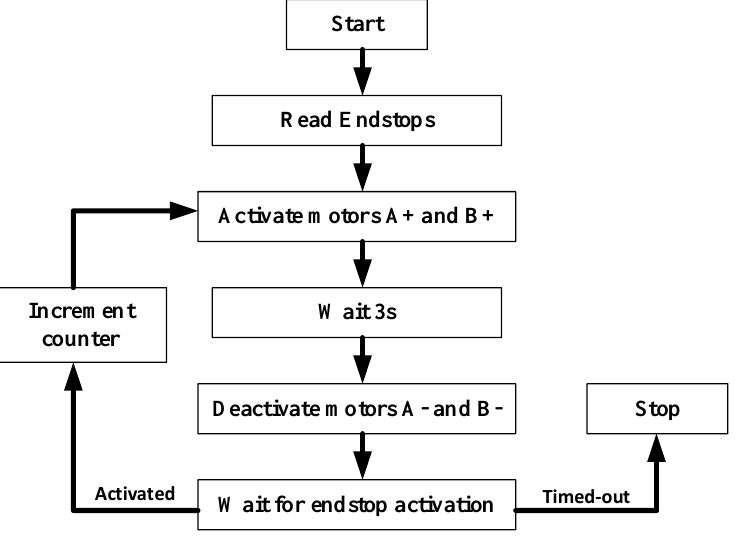
Figure 11. Control algorithm schematics.